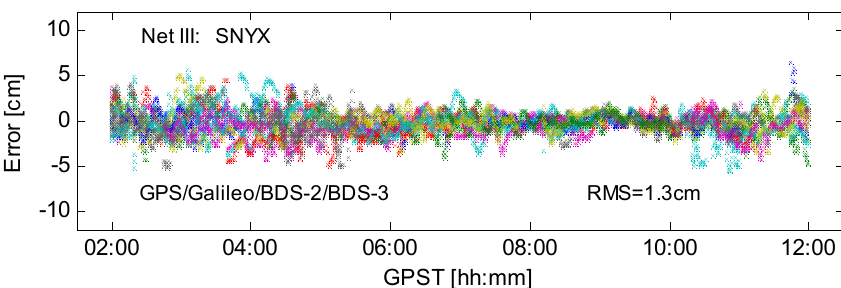
Figure 9. BSSD ionosphere interpolation errors of GPS/Galileo/BDS-2/BDS-3 at station SNYX.